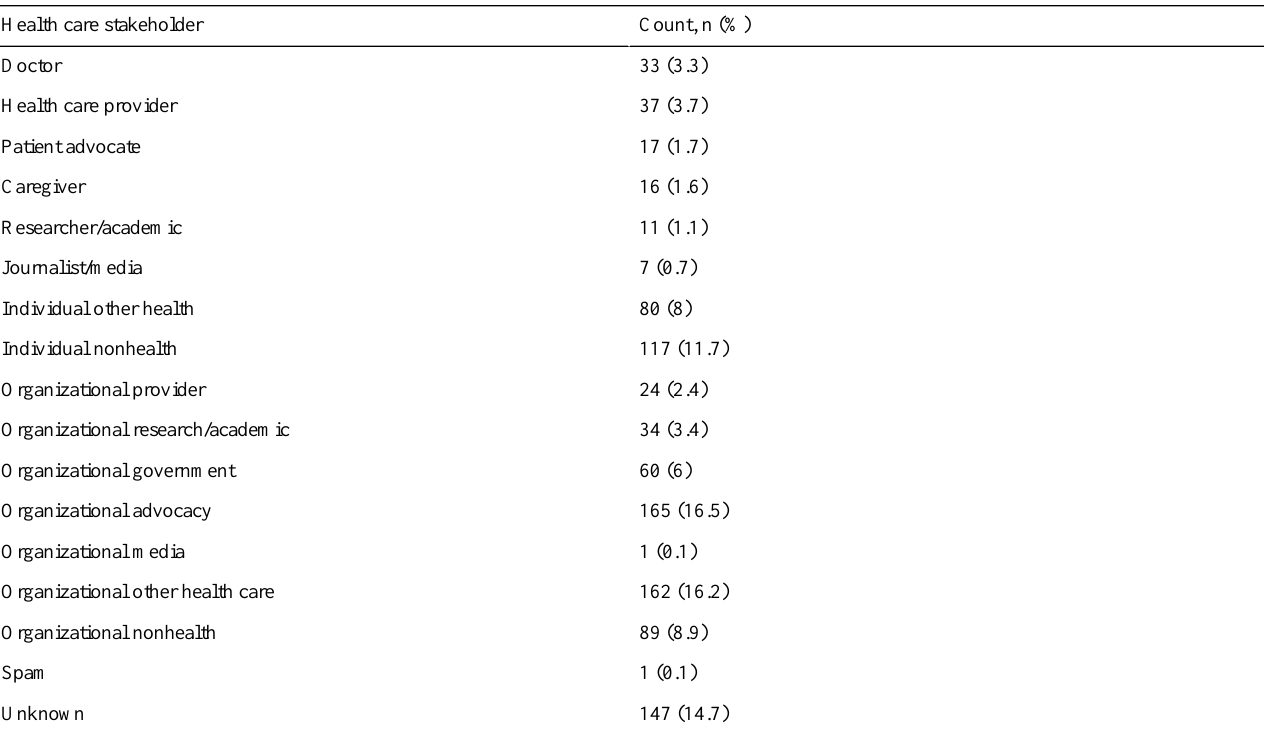
Table 3. Top health care stakeholders by tweets for 1000 #SaludTues participants between November 1, 2014, and August 31, 2018